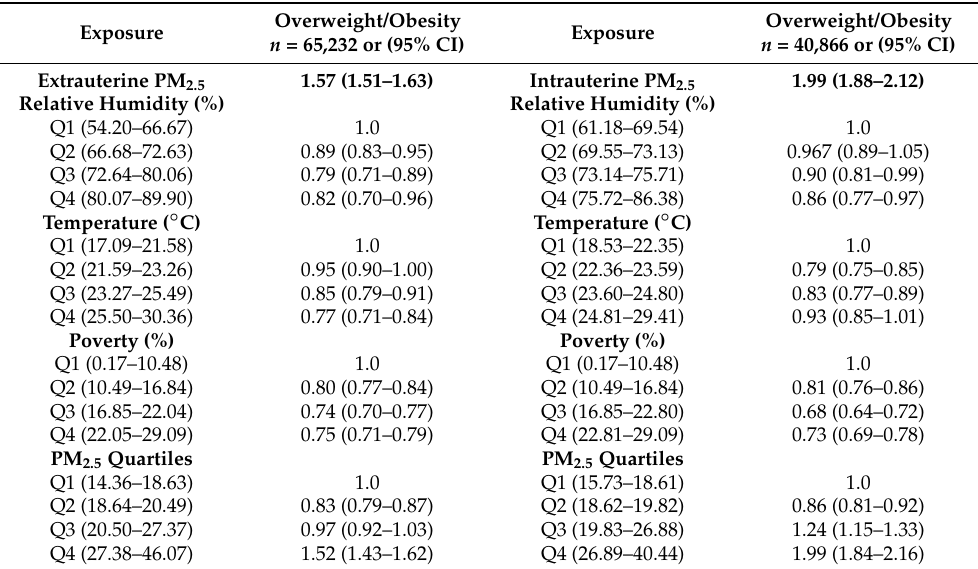
Table 3. Conditional regression analysis between a ten µ g/m 3 increase in intrauterine and extrauter- ine exposure PM 2.5 and O/O cases in Lima and Callao.